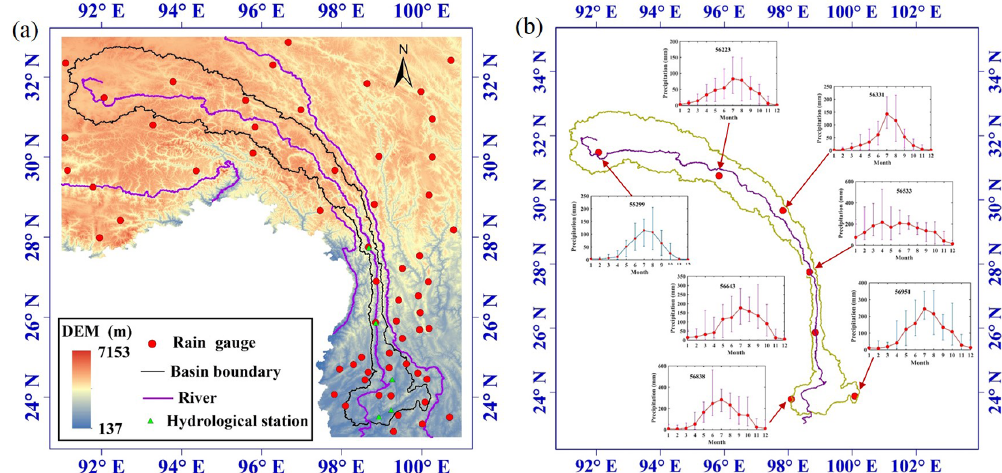
Figure 2. (a) Terrain map of the study area (the Nu-Salween basin and its adjacent areas). (b) The distribution of rainfall during the year across the Nu